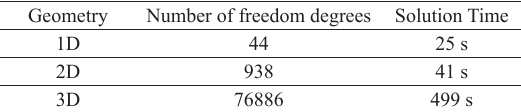
Table 6. Number of freedom degrees and solution time for the different geometries used in each interface studied.